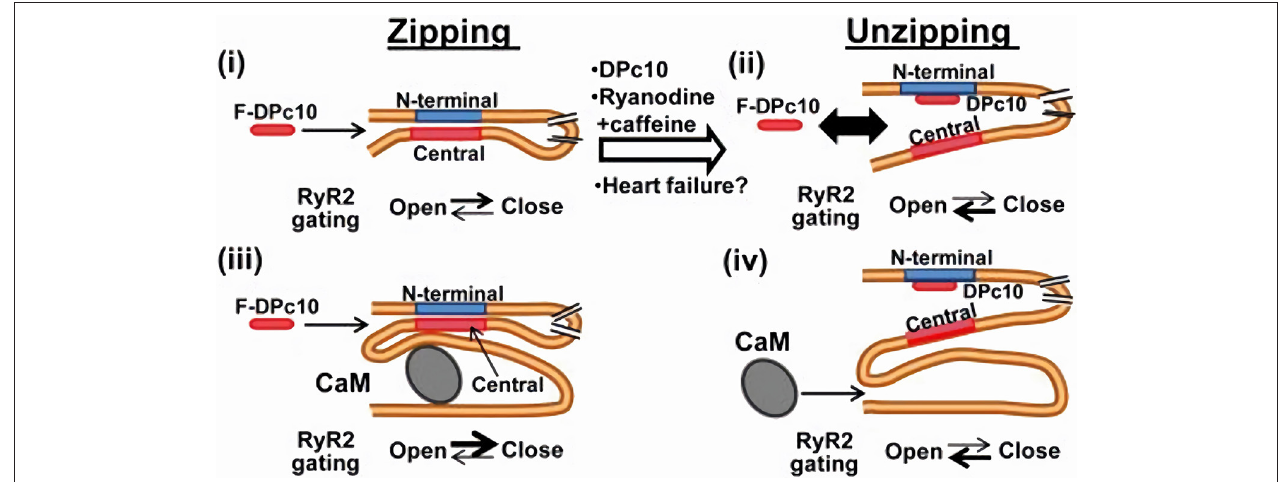
FIGURE 3 | CaM-dependent modulation of RyR2 channels. RyR2 closed state is stabilized by the interaction (zipping) between “terminal” and “central” regions of the N-terminal (cytosolic) tail of the protein. If such interaction is removed (unzipping), the channel closed state is destabilized. Apo-CaM binds to a domain distal to the “zipping” one, but the resulting conformation allosterically facilitates the zipping interaction, thus stabilizing RyR2 closed state. CaM and F-DPc10 (a peptide obstructing the zipping interaction) allosterically “compete” for binding to RyR2. Similarly, the unzipped state, promoted by drugs and reactive oxygen species which facilitate RyR2 opening, reduces RyR2 affinity for CaM ( 67). F-DPc10 is a peptide fragment designed to prevent the interaction between the central and N-terminal protein domains (a tool in testing the unzipping model). From Oda et al.